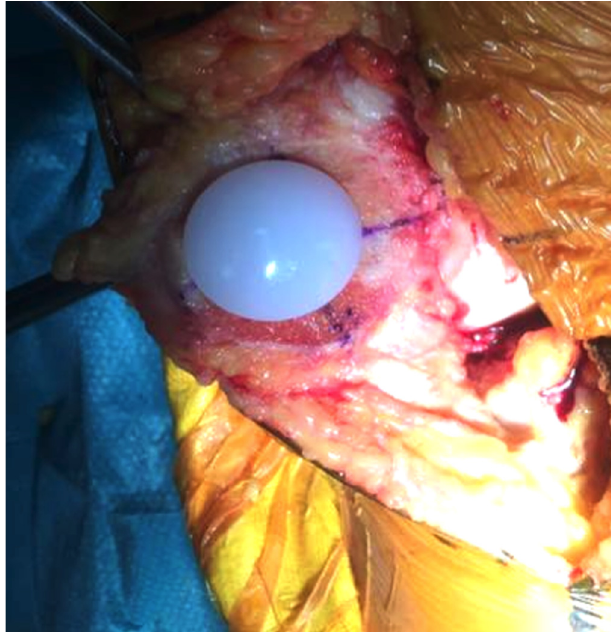
Figure 10. Final patellar component in